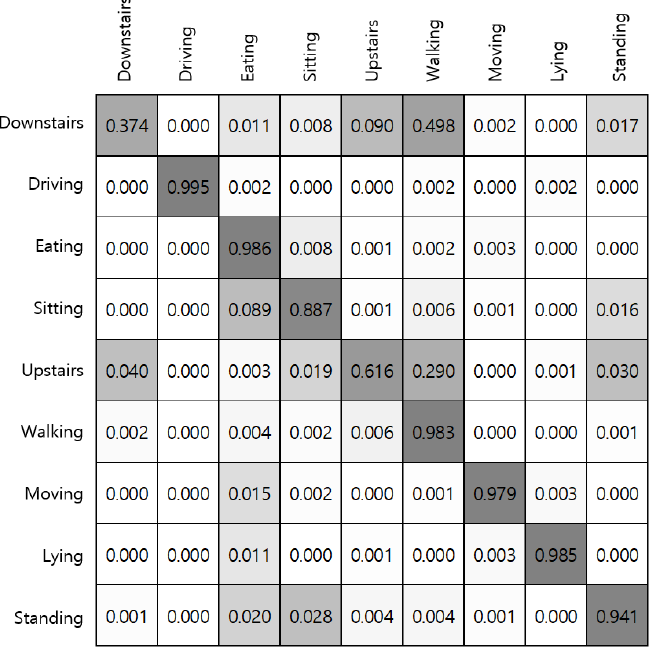
Figure 11. Confusion matrix for each activity. The x-axis stands for the ground truth and the y-axis denotes predicted labels through voting ensemble.